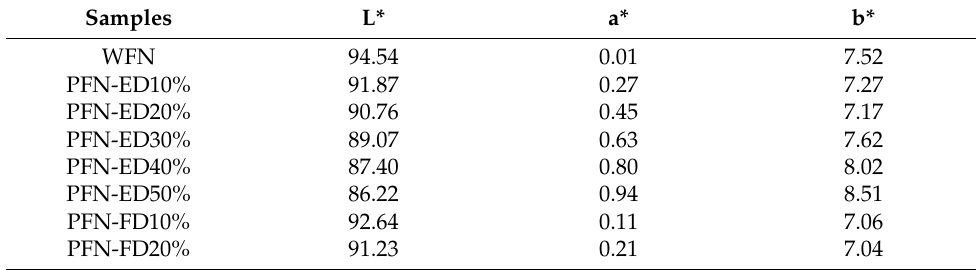
Table 5. Color properties of fresh